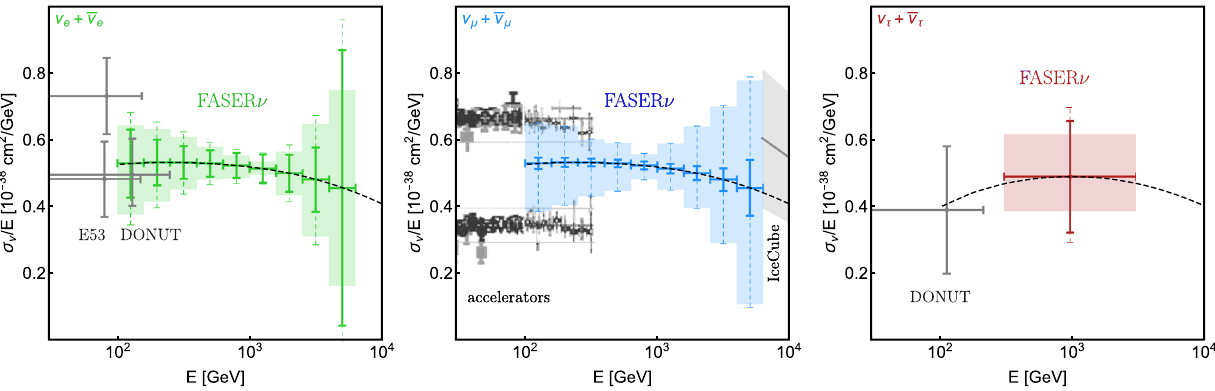
Fig. 17 Left : The 30 kg pilot neutrino detector that was installed in the TI18 tunnel in 2018. It collected 12.5 fb − 1 of data. Center : Recon- structed tracks in 2 mm × 2 mm × 10 emulsion films. About 13,000 trackswereobserved,correspondingtoabout3 × 10 5 tracks / cm 2 . Right :